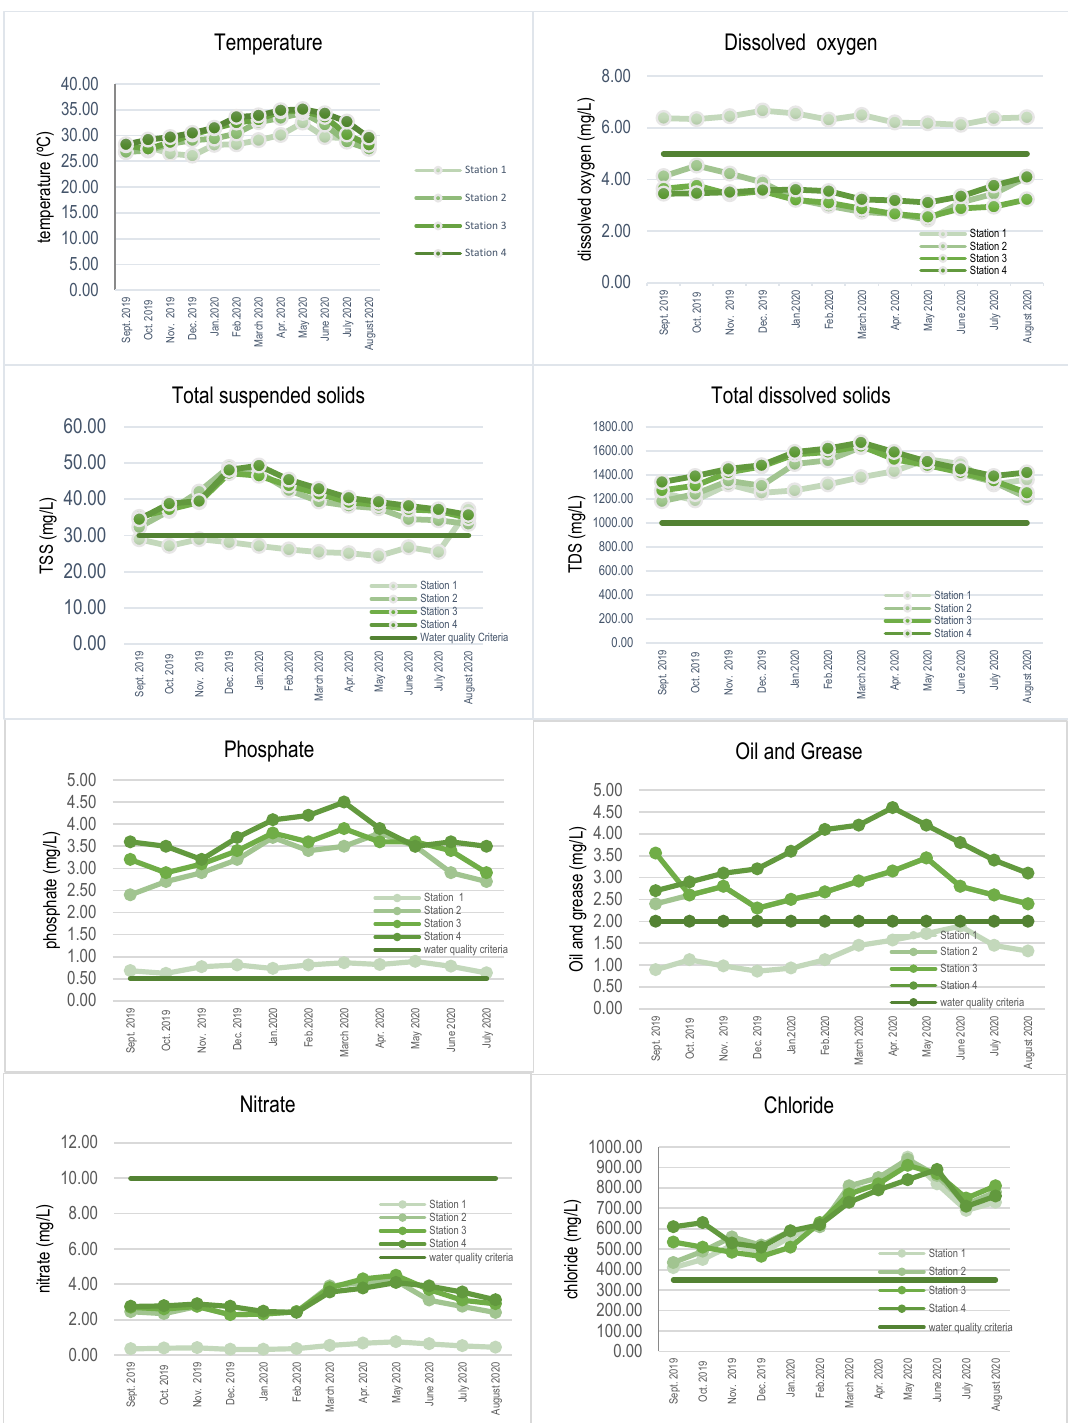
0.002.004.006.008.0010.0012.00 Fig. 4: Measured concentrations of physical –chemical water quality parameters in all stations